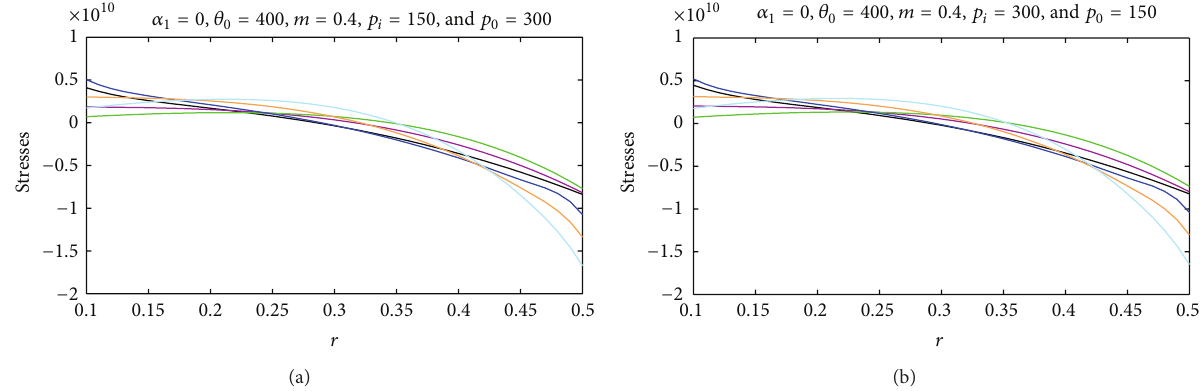
Figure 6: Elastic-plastic stresses in a rotating cylinder with variable thickness and variable density with thermal effects ( 𝜃 0 = 400 ) with parameters 𝑒 1 = 0, 1, 2 and strain hardening measure 𝑚 = 0.4 under internal and external pressure.